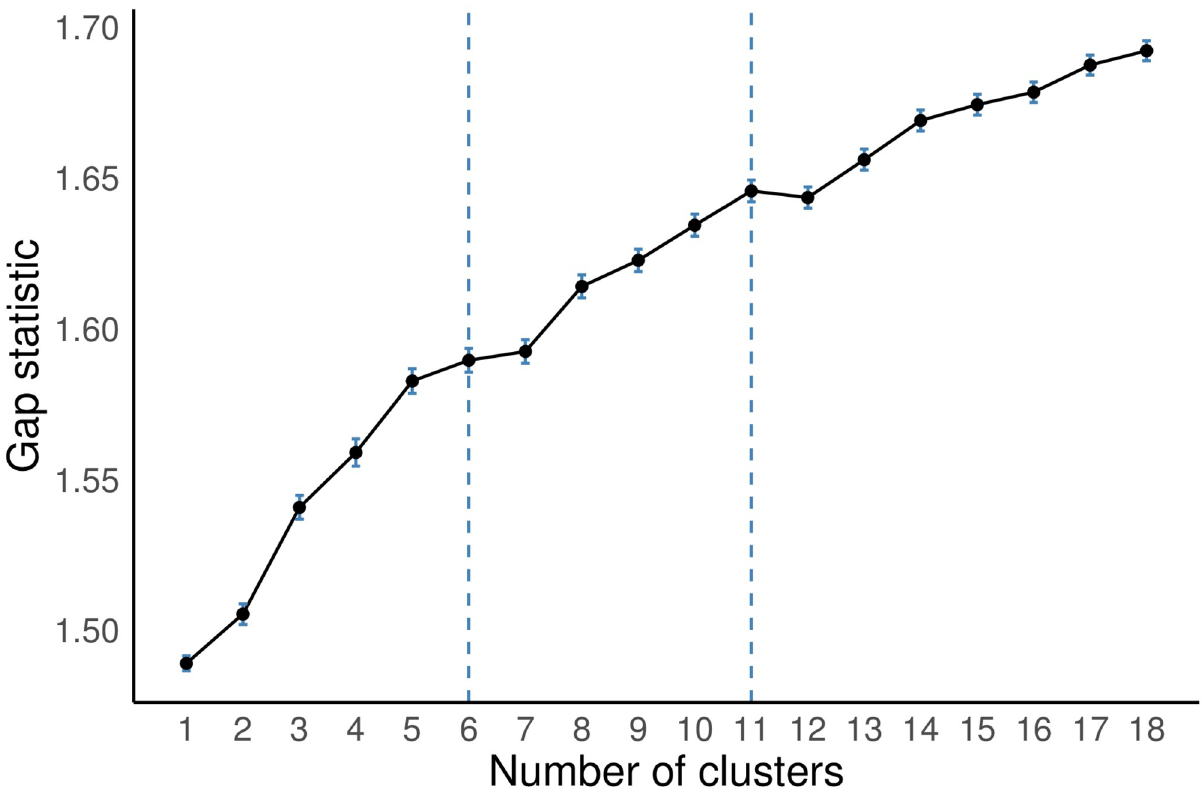
Fig 4. Gap statistic for the hierarchical